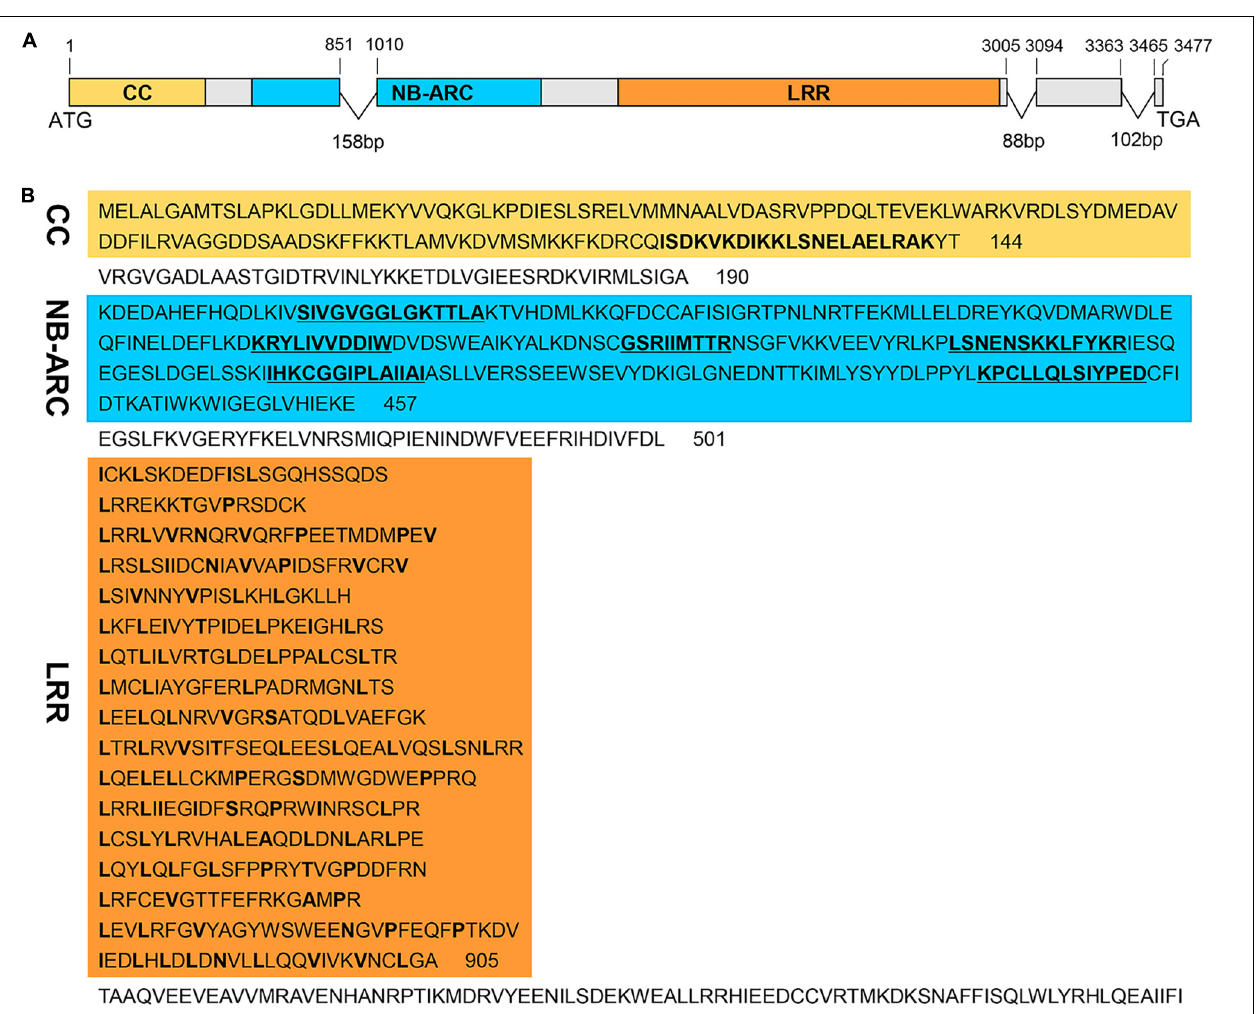
FIGURE 2 | Structure of RppM and its predicted protein domain and motifs. (A) Gene structure of RppM . The boxes represent exons, and lines denote introns. ATG and TGA are the translation start and stop codons, respectively. Yellow, blue, and orange regions represent the coiled-coil (CC) coding region, nucleotide-binding site (NBS), and the leucine-rich repeat (LRR) domain, respectively. (B) The predicted domain and motifs of RppM. The CC motif is indicated in bold font in the yellow region. The NBS domain is shown in blue, and the six conserved motifs (P-loop, Kinase2, RNBS-B, RNBS-C, GLPL, and MHDV) of the NBS are indicated in bold font. The C-terminal LRR domain, shown in orange, contains 17 LRR